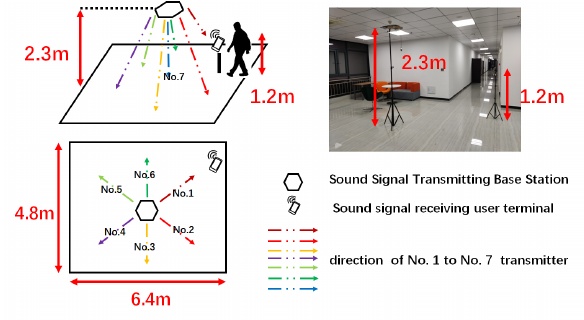
Figure 7. Indoor environment and base station deployment